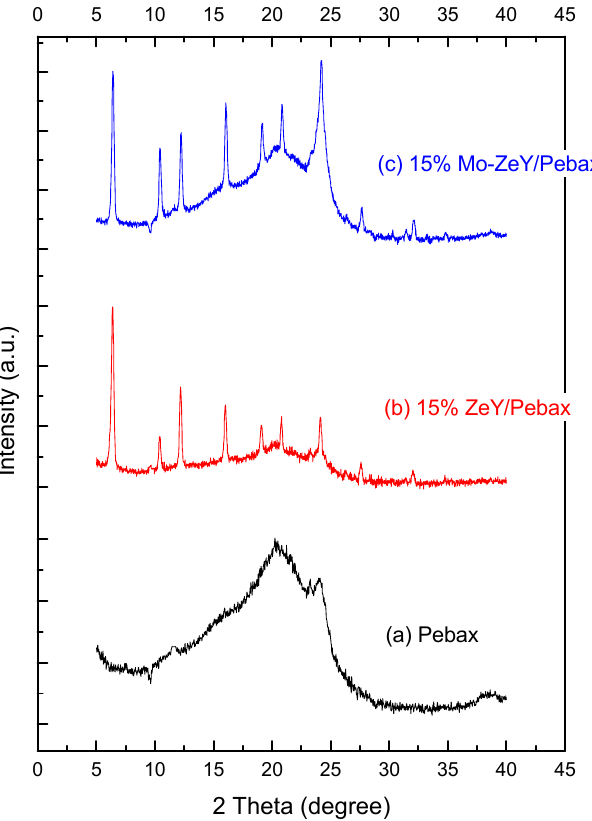
Figure 7. XRD patterns of ( a ) Pebax, ( b ) Pebax + 15 wt.% ZeY, and ( c ) Pebax + 15 wt.% Mo-ZeY membranes.